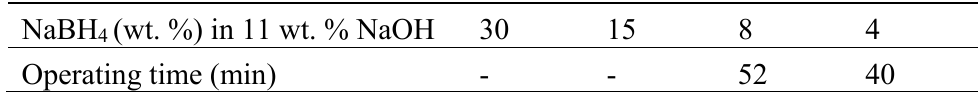
Table 3. Fuel concentration optimization data for five-cell DBFC stack with optimized 8